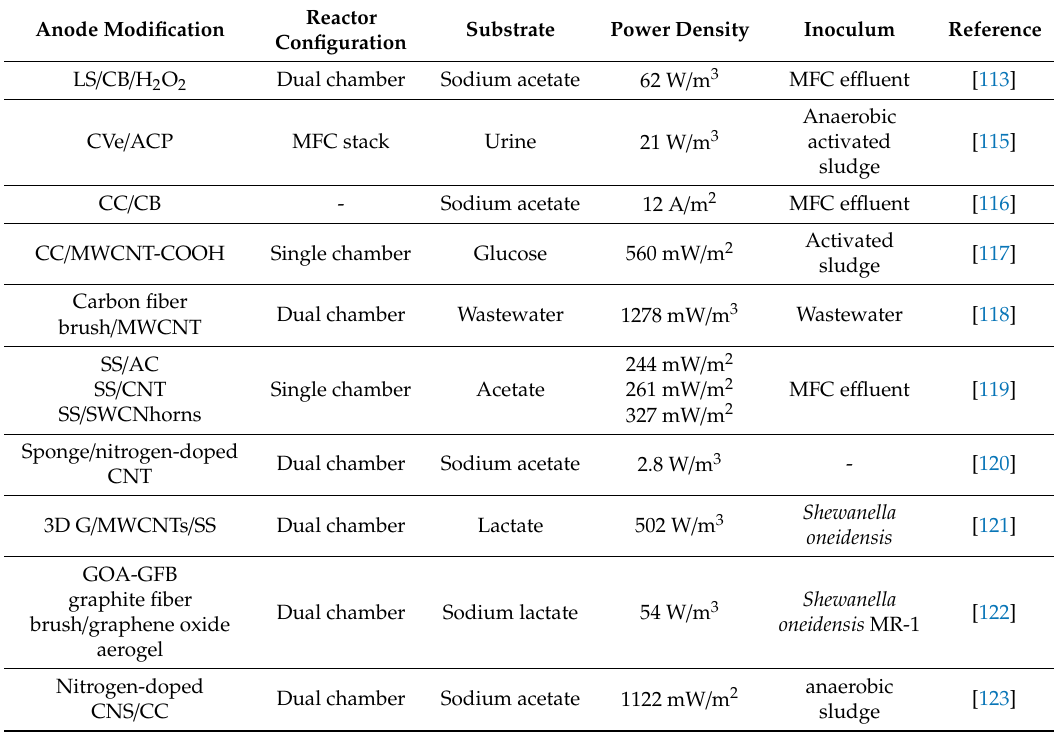
Table 2. Performance of MFCs with an anode modified with carbon